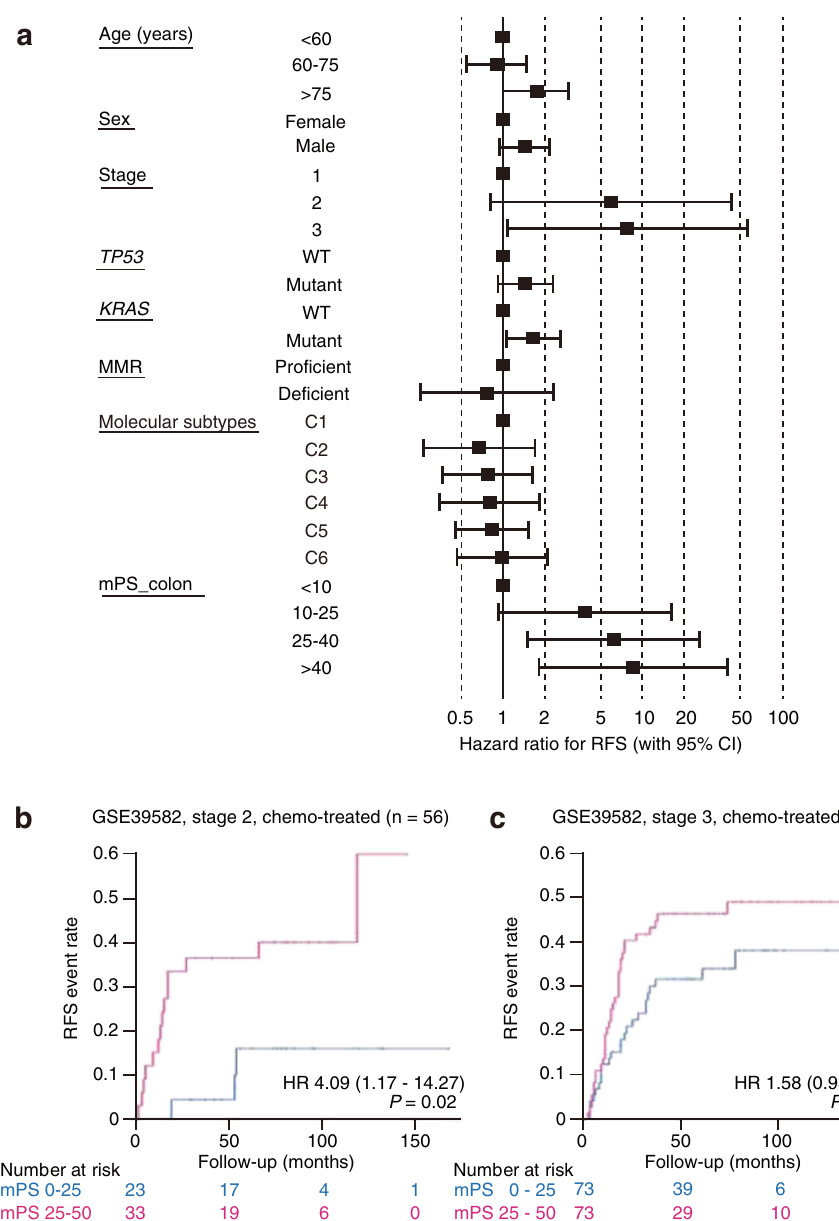
Fig. 4 mPS_colon is an independent prognostic indicator. a Multivariate analysis of relapse-free survival (RFS) for metastasis-free colorectal cancer patients in the GSE39582 cohort. Hazard ratios (HRs) and their 95% con fi dence intervals (CIs) were calculated with the Cox proportional hazard model. b , c Kaplan – Meier curves of RFS according to mPS_colon for stage 2 ( b ) or stage 3 ( c ) patients treated with chemotherapy. HRs (with 95% CIs) and log-rank P values are shown. Only patients with available information are